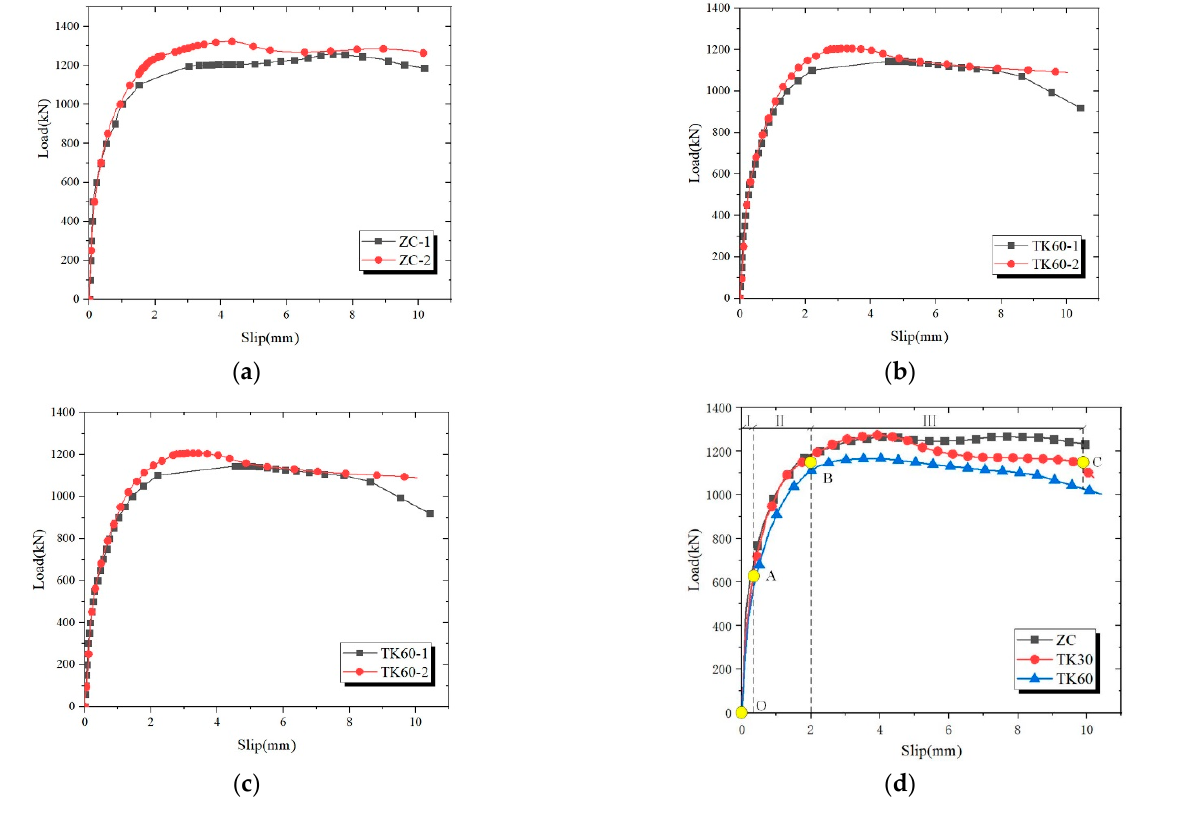
Figure 13. Load-slip curve of specimens: ( a ) ZC group; ( b ) TK30 group; ( c ) TK60 group; ( d ) Compari- son of average curves. Note: I elastic stage; II elastic-plastic stage; III plastic damage stage. Yellow circles are the endpoints of each